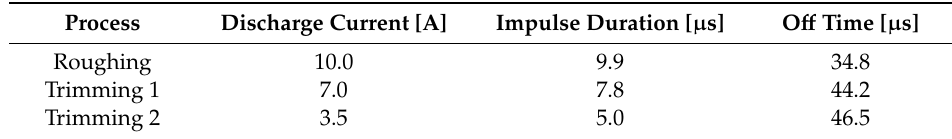
Table 1. EDM characteristics for die sinking experiments.